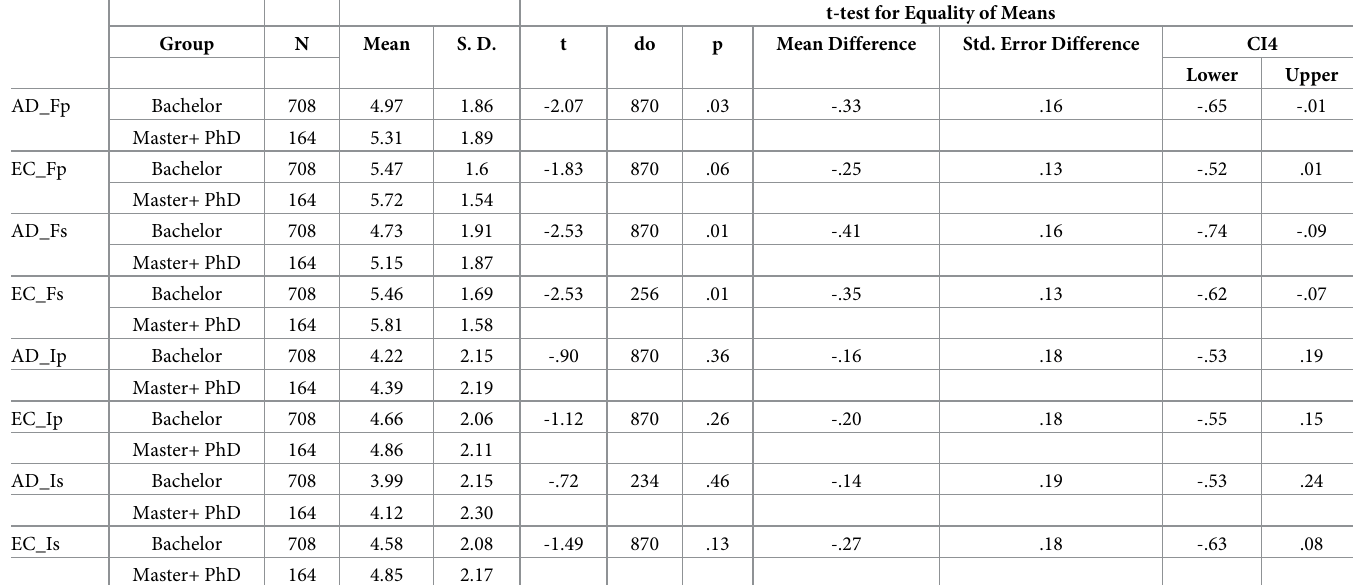
Table 3. Significant t-test results: Facebook/Instagram scale–degree